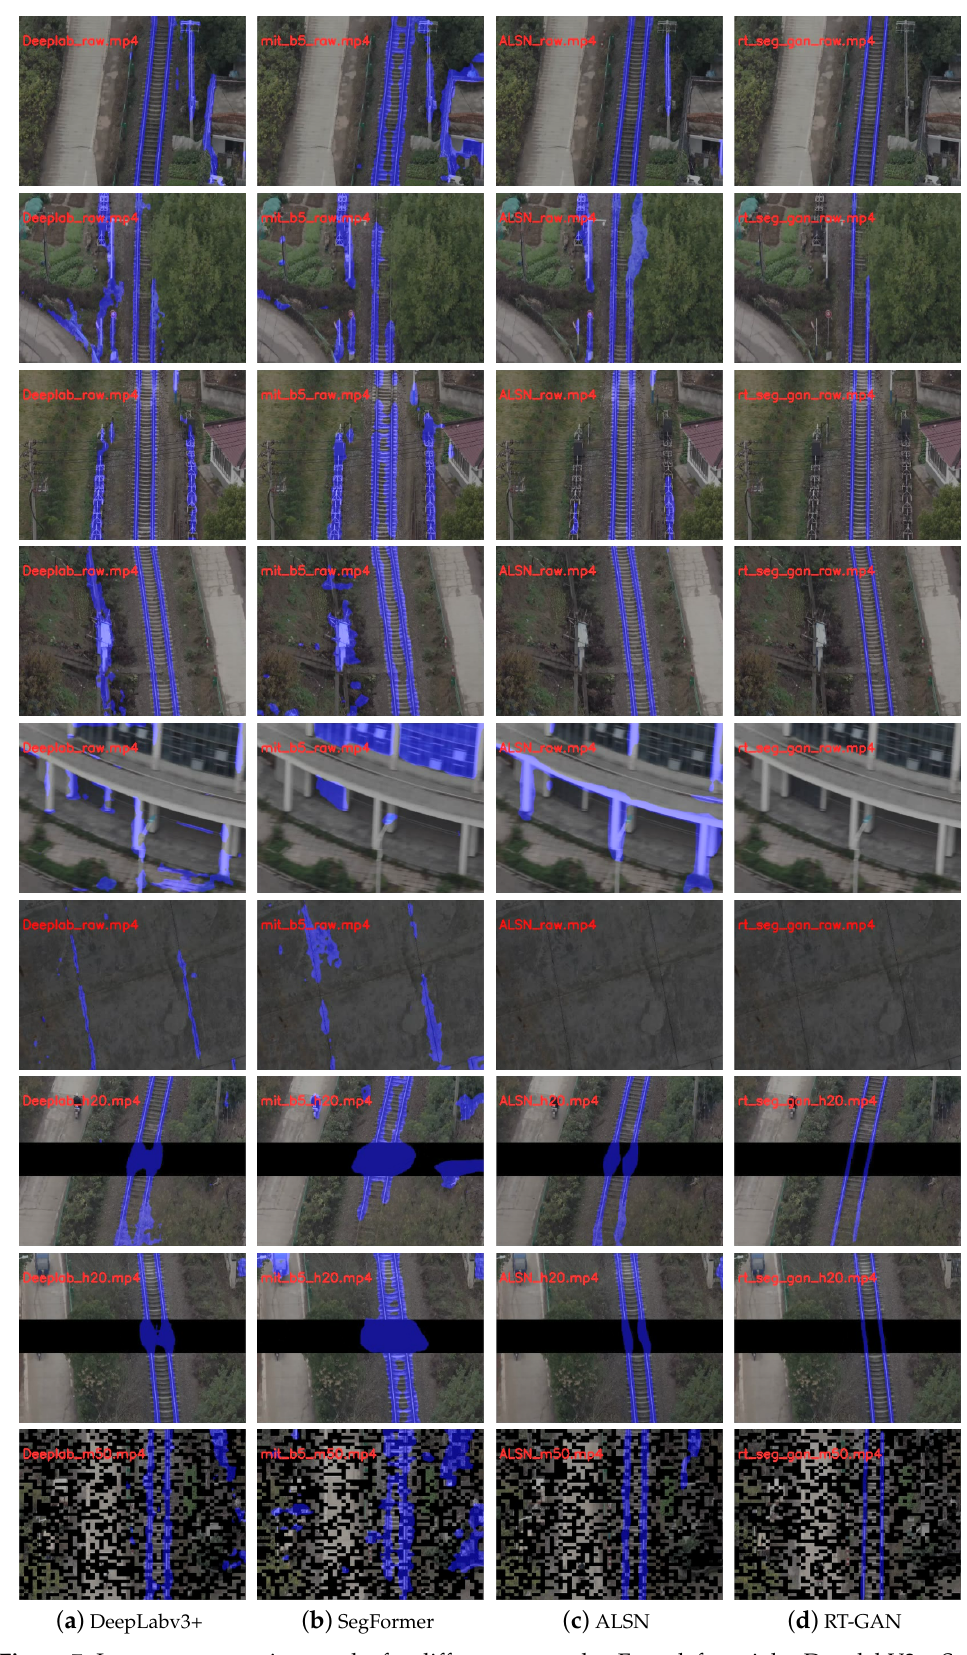
Figure 7. Image segmentation results for different networks. From left to right, DeeplabV3+, Seg- former (mit_b5), ALSN and RT-GAN